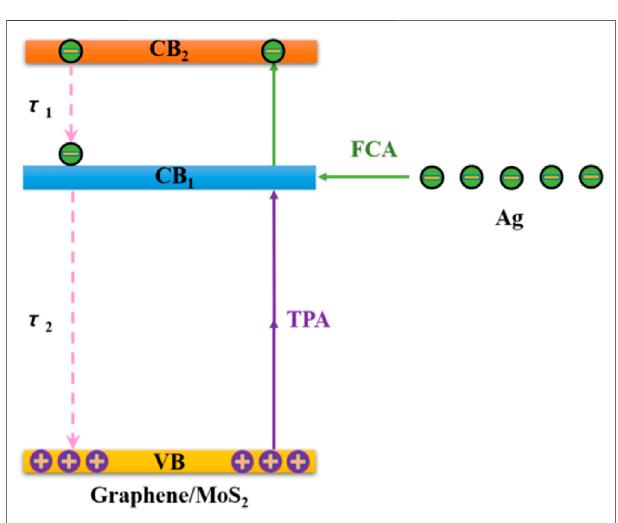
FIGURE7| Theenergyleveldiagramofthegraphene/MoS 2 /Agthin fi lm.